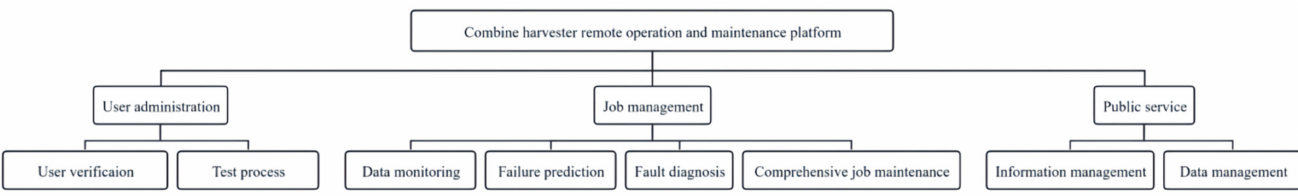
Figure 3. Platform function block